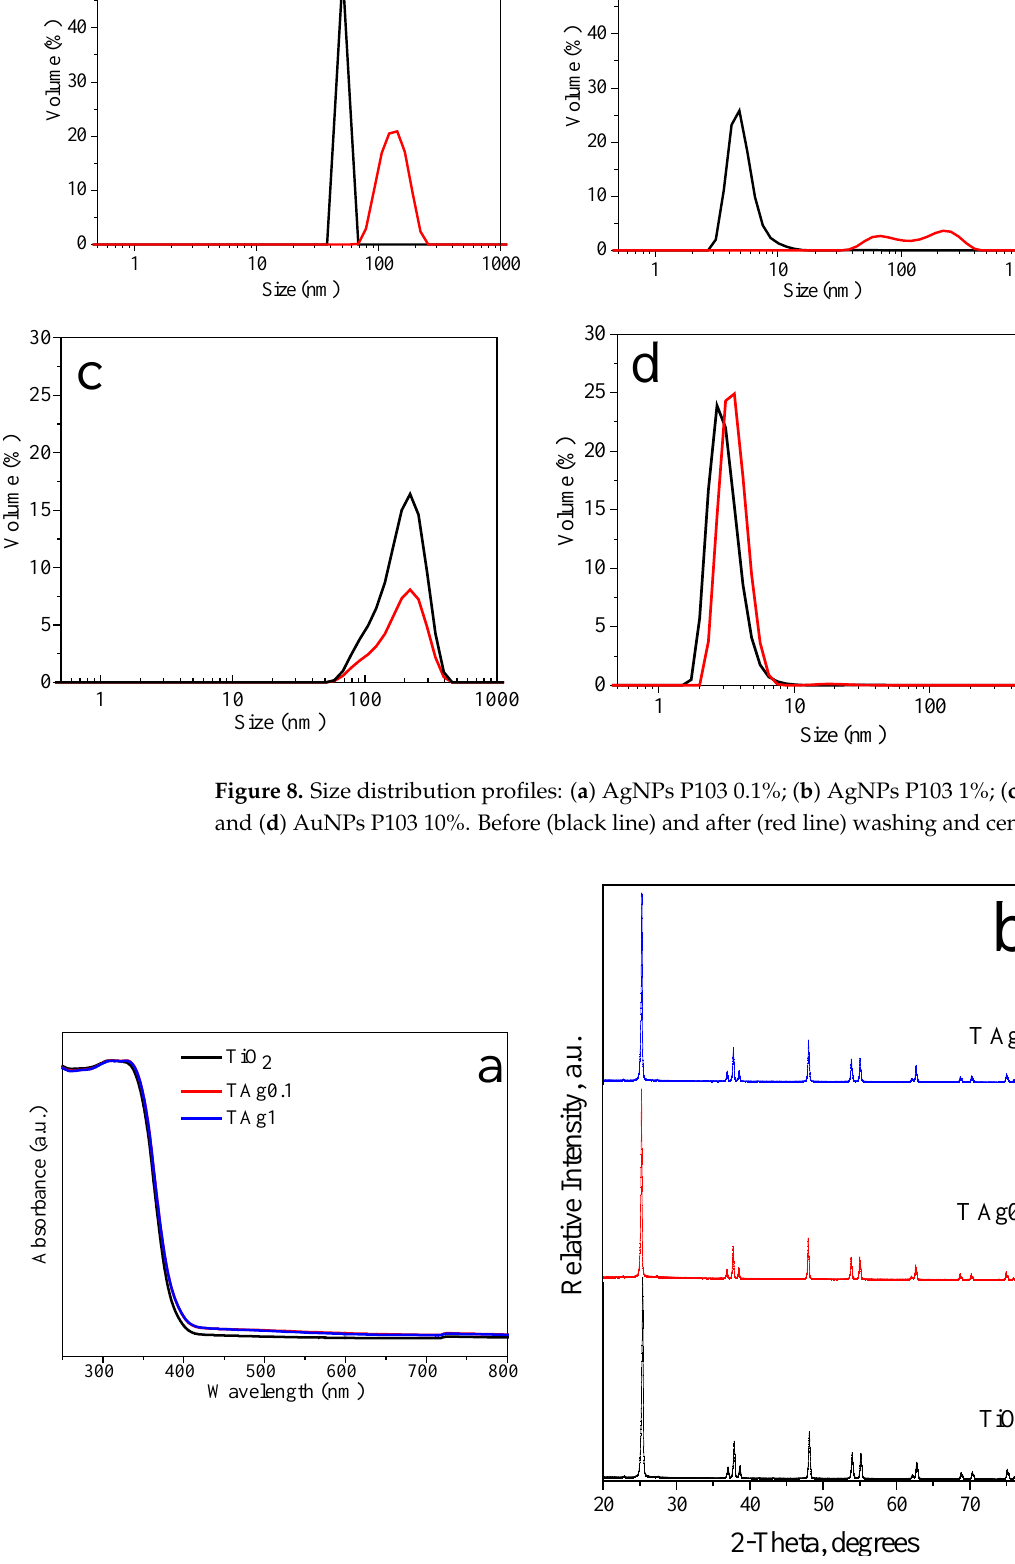
Figure 9. ( a ) DRS and ( b ) DRX of TiO 2 and TiO 2 decorated with NPs; TEM of ( c ) TAg0.1 and ( d ) TAg1; ( e ) EDS of TAg0.1. The optical properties of TiO 2 -Au composites can be investigated by diffuse reflec- tance UV-Vis spectroscopy, because the LSPR peaks of AuNPs are very sensitive to size